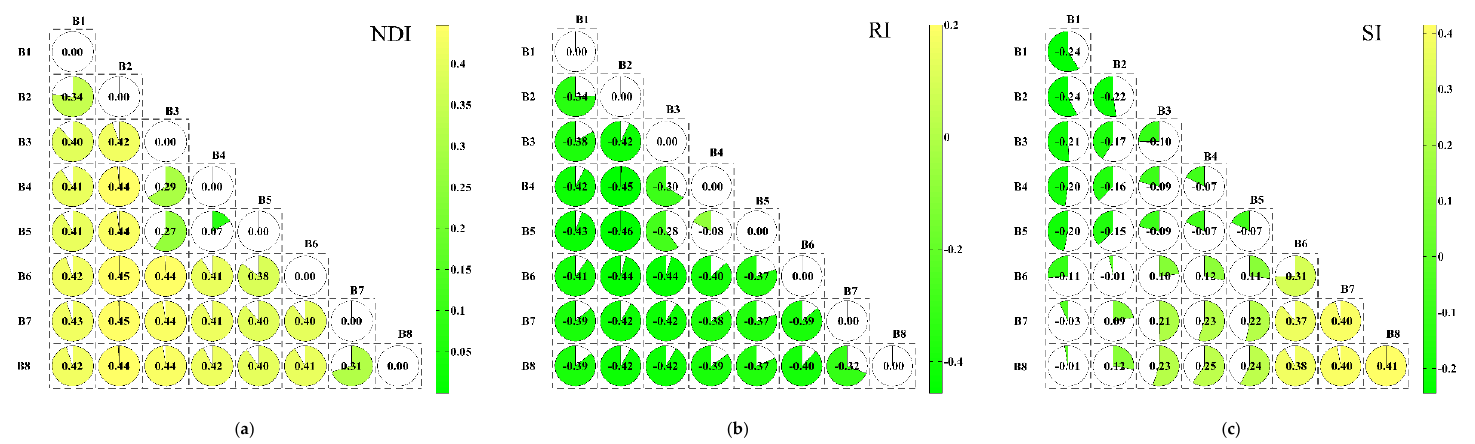
Figure 9. The correlation analysis between EC and optimized spectral indices based on reciprocal inverse (1/R). ( a ), ( b ), ( c ) represent the correlation EC with NDI, RI, and SI, respectively.